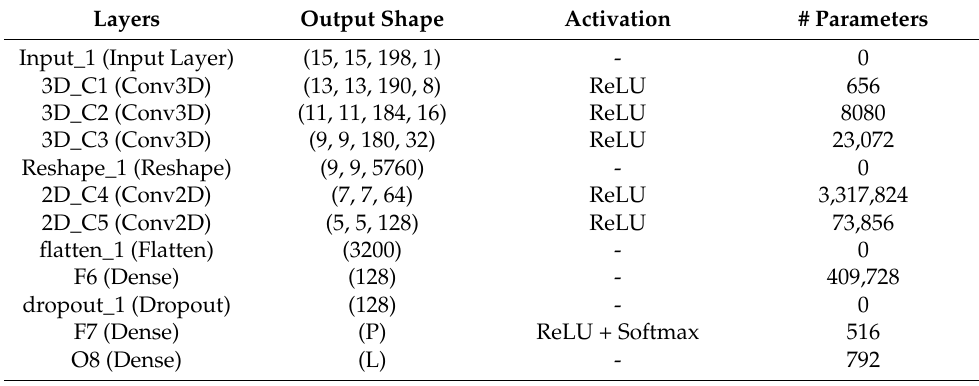
Table 1. Detailed summary of the proposed DHCAE